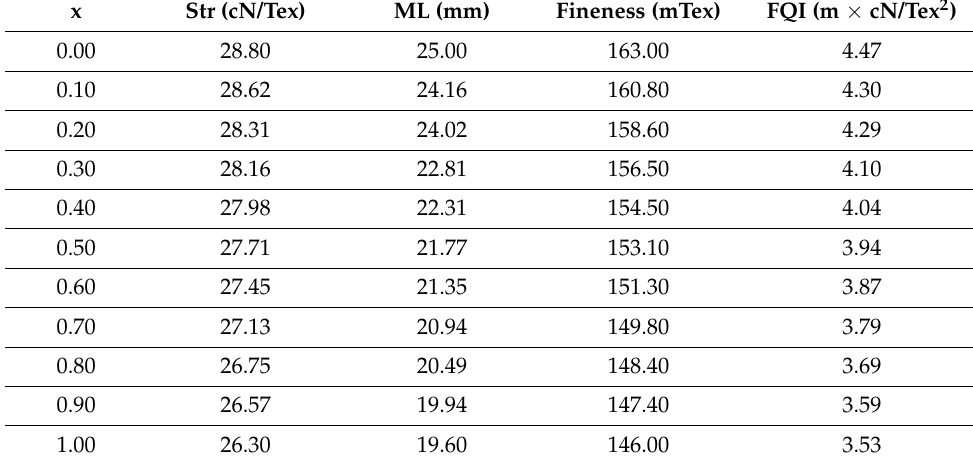
Table 4. FQI for the V2 and W1 blend.